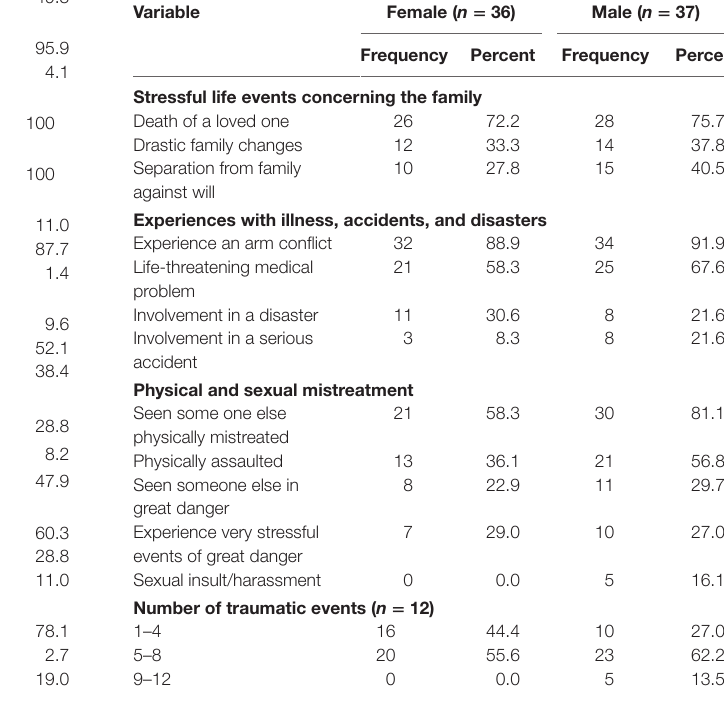
TaBle 2 | Frequency of stressful life events by gender among child and adolescent iDPs, Kaduna, nigeria.